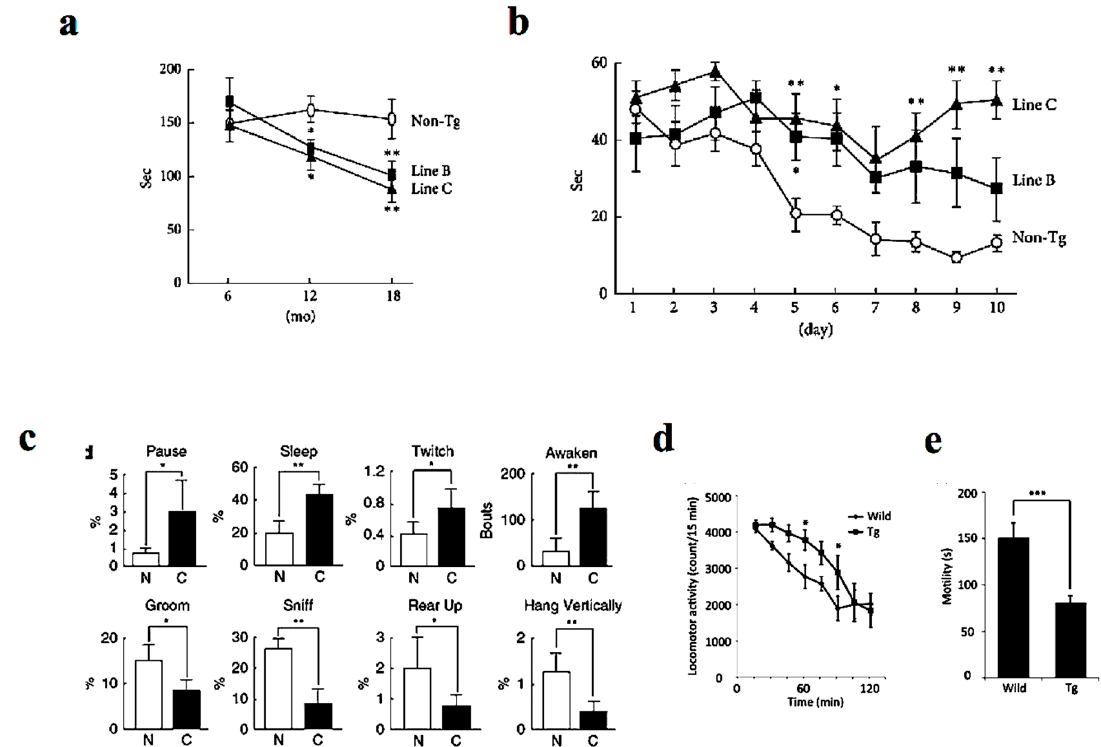
Figure 2. Behavioral alterations in P123H β S tg mice. ( a ) The Tg mice expressing DLB-linked P123H β S were characterized by motor dysfunction as assessed by impaired motor performance on the rota-rod treadmill test at different ages. The motor deficits become apparent after approximately 12 months. ( b ) In contrast, memory disorders were more prominent as assessed by the water maze test (apparent at approximately 6 months). ( c ) Similarly, home-cage tests showed that spontaneous activity was decreased in the P123H β S mice (at around 6 months). Furthermore, the P123H β S mice exhibited depression-like behaviors as assessed from the results of the locomotor activity ( d ) and the tai suspension test ( e ) (6–10 months). Data are shown as mean ± SEM ( n = 8 ∼ 16). * p < 0.05, ** p < 0.01 and *** p < 0.001 versus non-Tg mice. Reprinted with permission from references [14,18]. To investigate the combined effect of P123H β S and α S, P123H β S Tg mice were subjected to